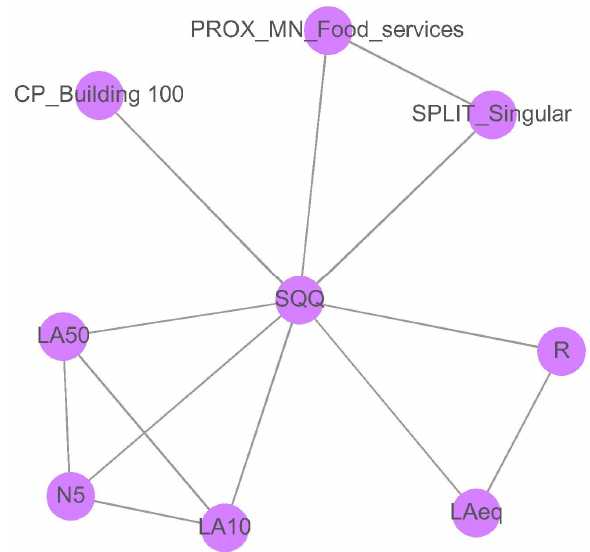
Figure 10. Inferred mRMR network topology of the soundscape quality (SQQ) for the pedestrian areas. The variables selected were “percentage of generic buildings in the aerial photograph within a distance of 100 m” (CP_Building_100), spatial metric “proximity” calculated for the land use “food services” (PROX_MN_Food), spatial metric “split” calculated for the land use “singular buildings” (SPLIT_Singular), sound pressure level exceeded 50% of time (LA50), A-weighted equivalent sound pressure level (LAeq), roughness (R), loudness(N5) and sound pressure level exceeded 10% of time.